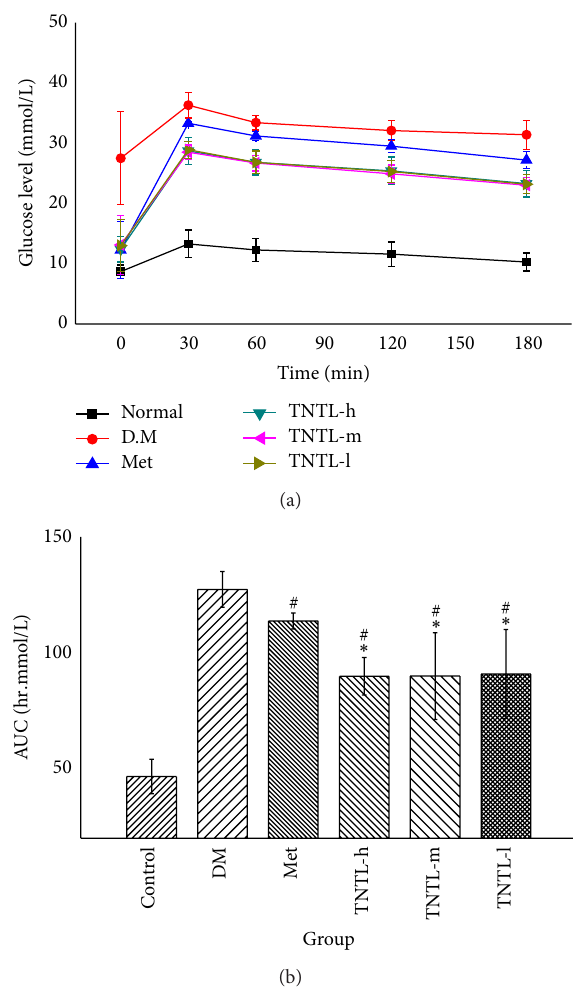
Figure 5: OGTT in db/db mice. TNTL reduced the blood glucose (a) after oral high dose of glucose and decreased the area under the glucose response curve (b). As expected, metformin significantly lowered the AUC in db/db mice compared with diabetic model. Furthermore, TNTL (TNTL-h, m, l = 3.6 g, 1.8 and 0.9 g/kg b.w., resp.) administration significantly lowered the AUC in db/db mice, compared with metformin. Control: C57BL, DM: db/db mice with untreated, Met: db/db mice treated with metformin, and TNTL-h, m, l: db/db mice treated with 3.6 g, 1.8 and 0.9 g/kg b.w., respectively. # 𝑃 < 0.05 compared with DM group. ∗ 𝑃 < 0.05 compared with metformin